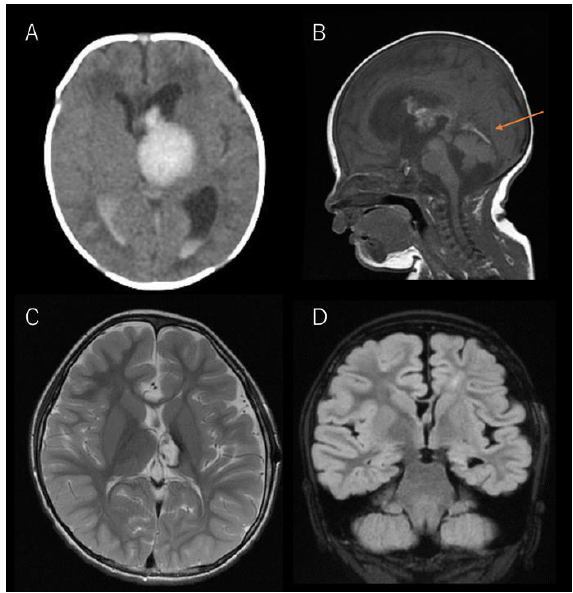
Figure 1. Brain magnetic resonance imaging (MRI) and computed tomography (CT) of the patient. ( A ) Axial CT image at 5 days of age. Thalamic hemorrhage perforating into the lateral and third ventricles is observed. ( B ) Sagittal T1-weighted image at 29 days of age. A high-intense, linear lesion is observed over the tentorium cerebelli (arrow), which is presumed to be the straight sinus thrombosis. ( C ) Axial T2-weighted image at 4 years of age. Cystic changes and hemosiderin deposition in the left thalamus are confirmed. No atrophy is observed on the right hemisphere. ( D ) Coronal fluid-attenuated inverted recovery image at 4 years of age. Slight atrophy of the left hemisphere, diffuse high-intensity lesions of the left cerebral white matter, and hippocampal atrophy are